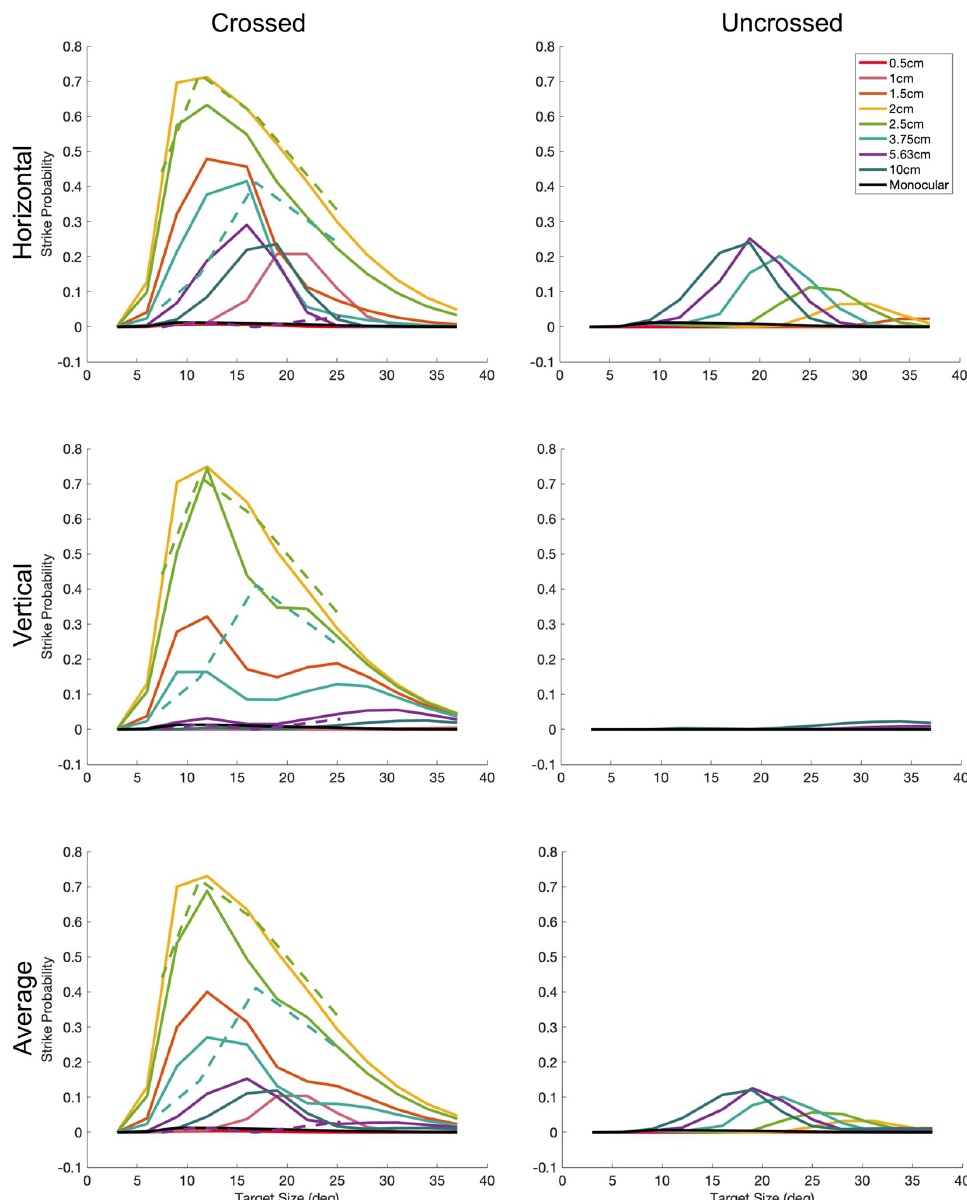
Fig 11. Mean number of strikes per trial predicted by the fitted model, as a function of stimulus size (horizontal axes) and simulated distance (colours). The top row is for targets moving horizontally over the sensor; the middle for stimuli moving vertically, and the bottom row for the average of both. The left panels are for crossed stimuli and the right for uncrossed. In all cases, the target passed directly over the receptive field center. The dashed lines in the crossed panels show the empirical data from [10] (Table 3) which the optimisation aimed to reproduce. In the experiments, the target had a spiralling motion with both horizontal and vertical components, so the same empirical data are shown in all three rows. As described in the Methods (see Table 3), the optimisation also aimed to predict zero strikes for stimuli at 10cm simulated distance, for monocular stimuli, and for stimuli of size 38˚ diameter. The other conditions—intermediate sizes and disparities, and uncrossed stimuli—were not constrained in the fitting, but the model structure ensures that plausible results are also obtained for these.